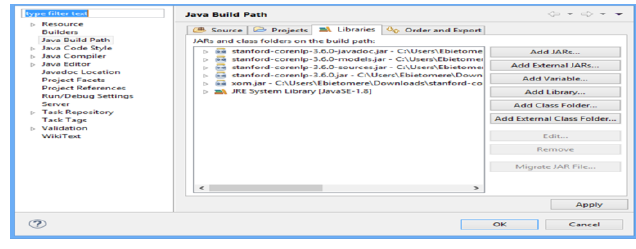
Fig. 9. Stanford Corenlp configuration build path in Eclipse.